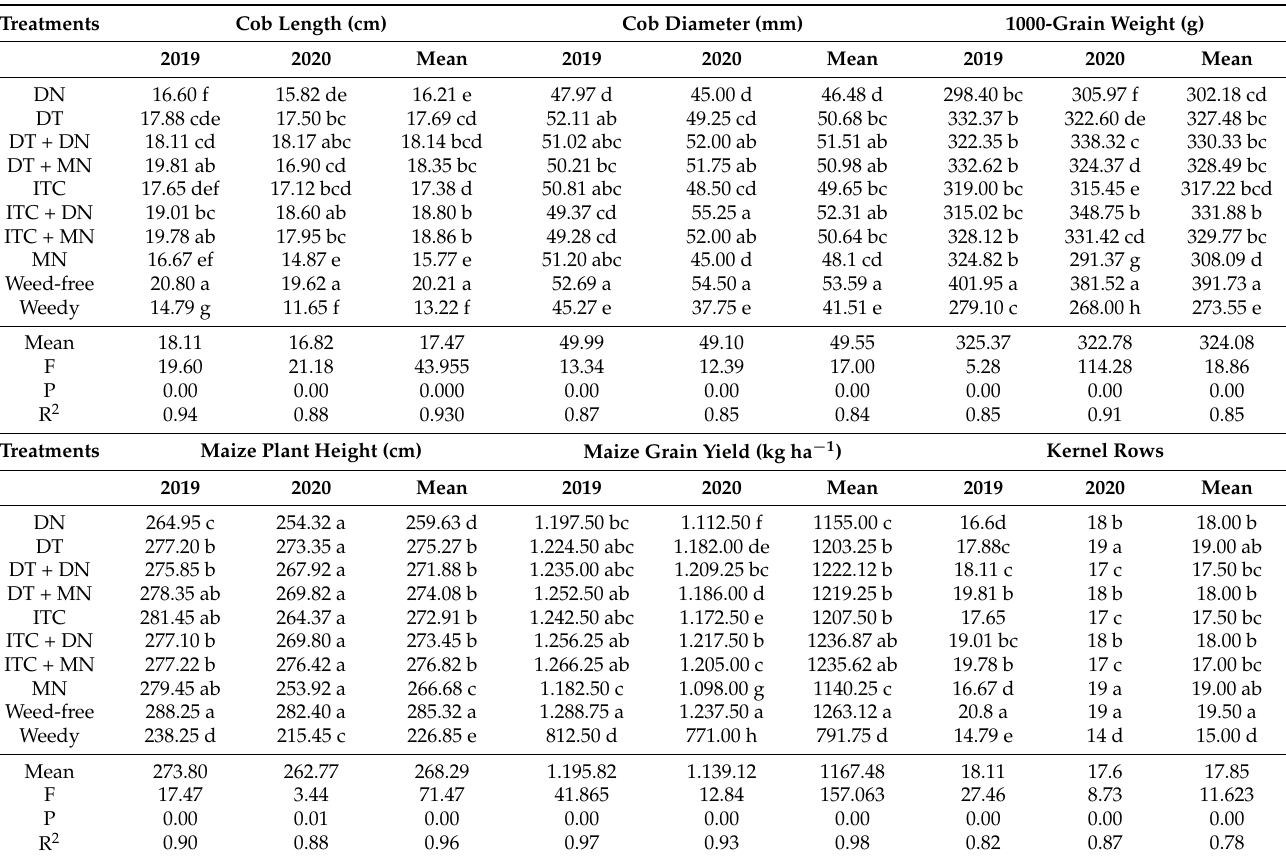
Table 7. Variance analysis of agronomic attributes of maize corresponding to the